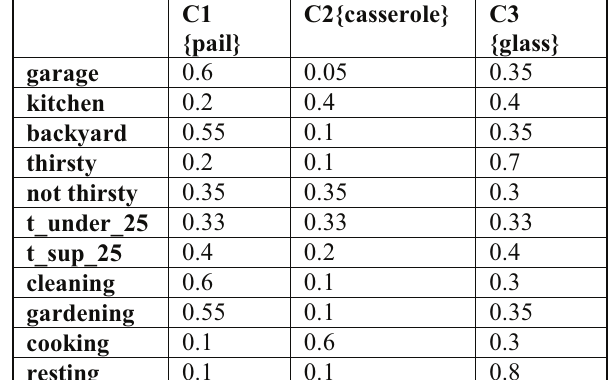
Table 1. Probabilities of likelihood of